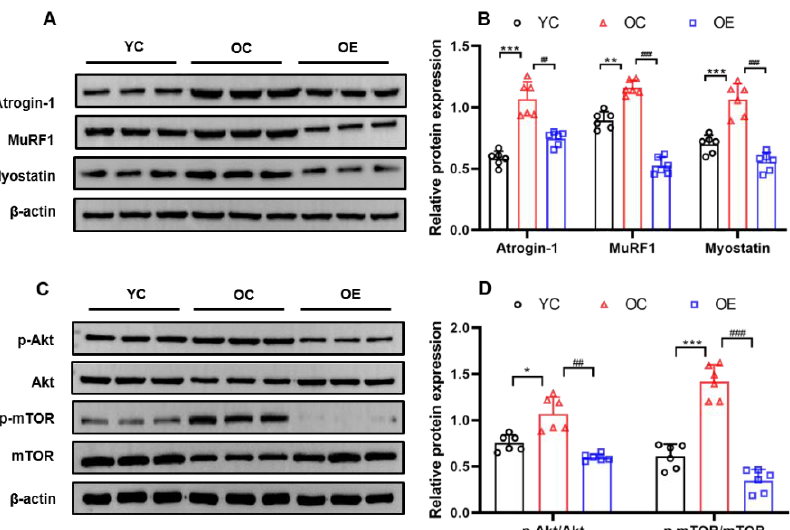
Figure 4. Western blot images suggested the down-regulation of Atrogin-1, MuRF1, and myostatin ( A , B ), and p-Akt Ser473 /Akt and p-mTOR Ser2448 /mTOR ( C , D ) associated with protein synthesis in gastrocnemius muscle of the aged mice upon lifelong aerobic exercise intervention. Equal protein loading was confirmed by β -actin. All data are presented as mean ± standard deviation (M ± SD) ( n = 6 mice per group). Group symbols: YC, black circle; OC, red triangle; OE, blue square. *** p < 0.001, ** p < 0.01 and * p < 0.05 vs. YC group; ### p < 0.001, ## p < 0.01 vs. OC group.